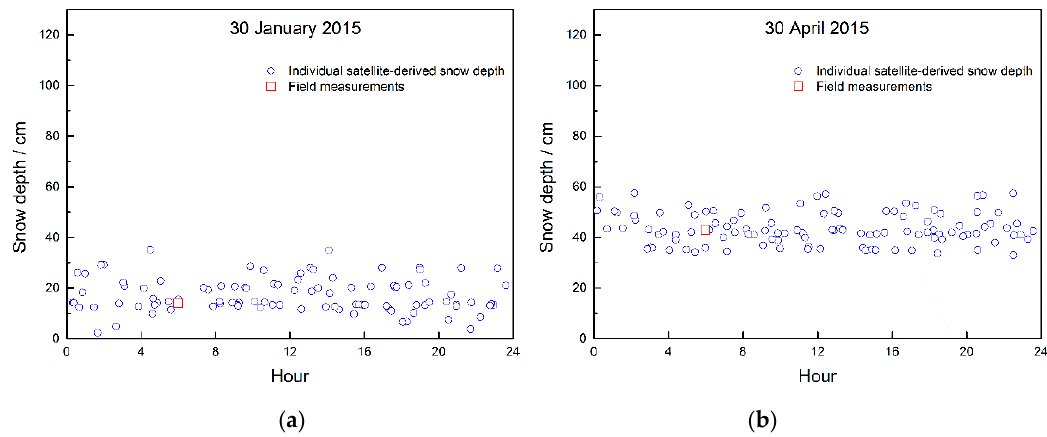
Figure 5. Scatterplot of individual satellite-derived snow depths versus in-situ snow depths on Jan. 30, 2015 ( a ) and Apr. 30, 2015 ( b ). Red squares represent the measured snow depths from field work, collected at UTC 6 h every day. Blue circles correspond to snow depths derived from different satellites.